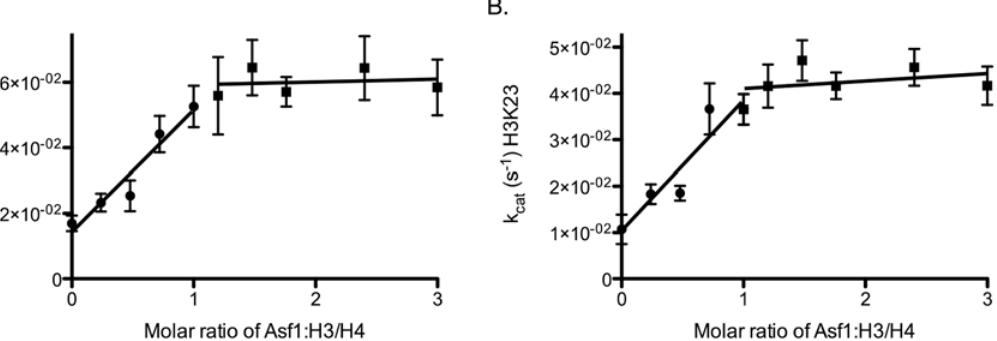
Fig 3. Stoichiometry of H3/H4-Asf1 for K9 and K23 in the presence of fixed concentrations of saturating acetyl-CoA and H3/H4. The detailed experimental conditions are described in the section “ Stoichiometry ” . The error bar represents the standard error in k cat(app) . Panels (A) and (B) show that the acetylation rates of H3K9 and H3K23, respectively, increase as a function of molar ratio of Asf1 to H3/H4, before all H3/H4 binds with Asf1. The inflection points of H3K9 and H3K23 are 1.21 and 1.09, respectively, indicating that the binding stoichiometry of Asf1 and H3/H4 dimer is approximately